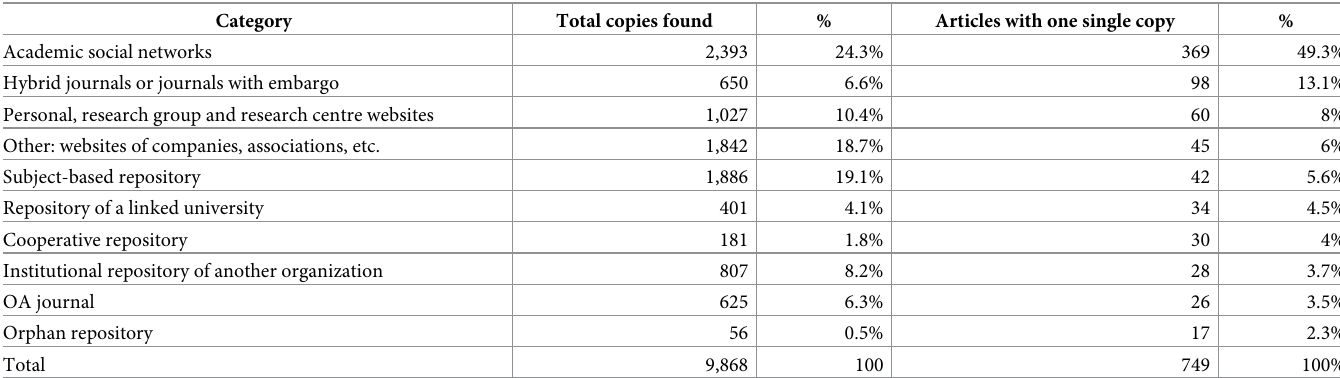
Table 4. Articles found on one site only.